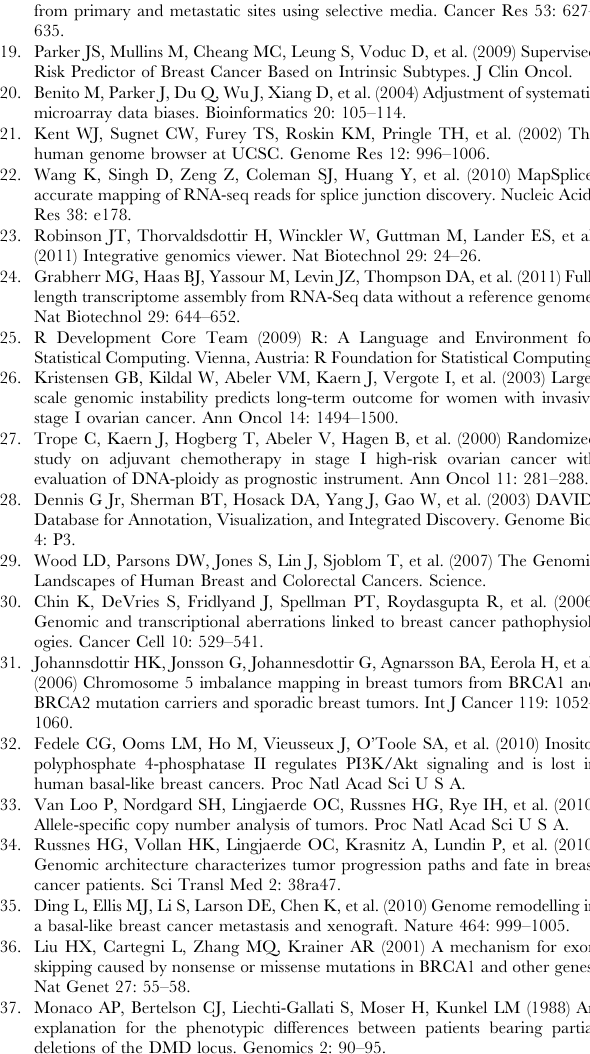
Figure S3 de novo assembly of targeted EGFR micro- amplification mRNA-seq data in the 990141B tumor sample. A) The two contigs aligned to the region of EGFR micro- amplification are visualized in space using the UCSC genome browser. B) The aligned region of the contigs are displayed in red with the unaligned base pairs at the start and end of the sequence written out. Sites within the aligned region where the unaligned GACCT sequence are observed are highlighted with black boxes. Figure S4 de novo assembly of targeted BCL11A micro- deletion mRNA-seq data in the UNC040182B tumor sample. The contig aligned to the region of BCL11A micro- deletion is visualized in space using the UCSC genome browser, with the location of the reference exon site displayed. A magnified view of the region is also provided. Table S1 Clinical data table. Table containing all information on the human breast samples used in this study including outcomes data, microarray and GEO accession number IDs.